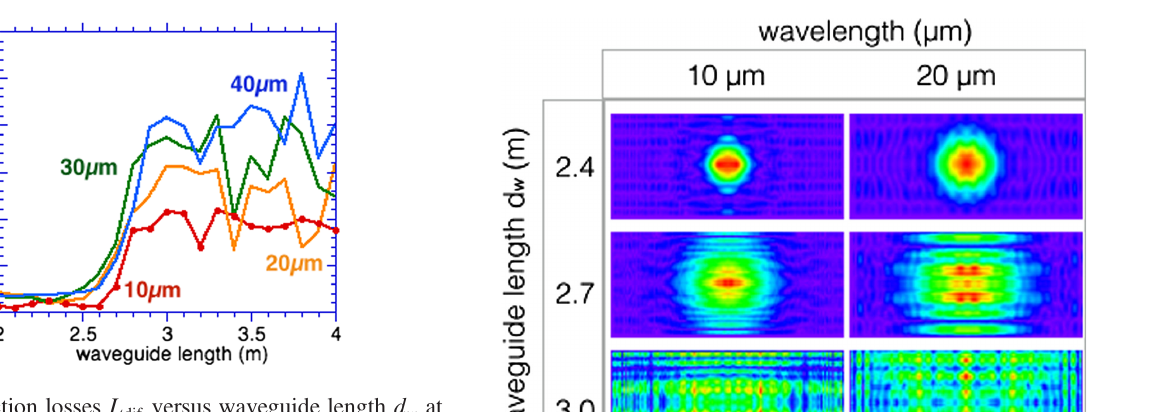
at w FIG. 16. Amplitude profile of the laser, at the waveguide output (point A in Fig. 9), for various wavelength λ and waveguide length d . w